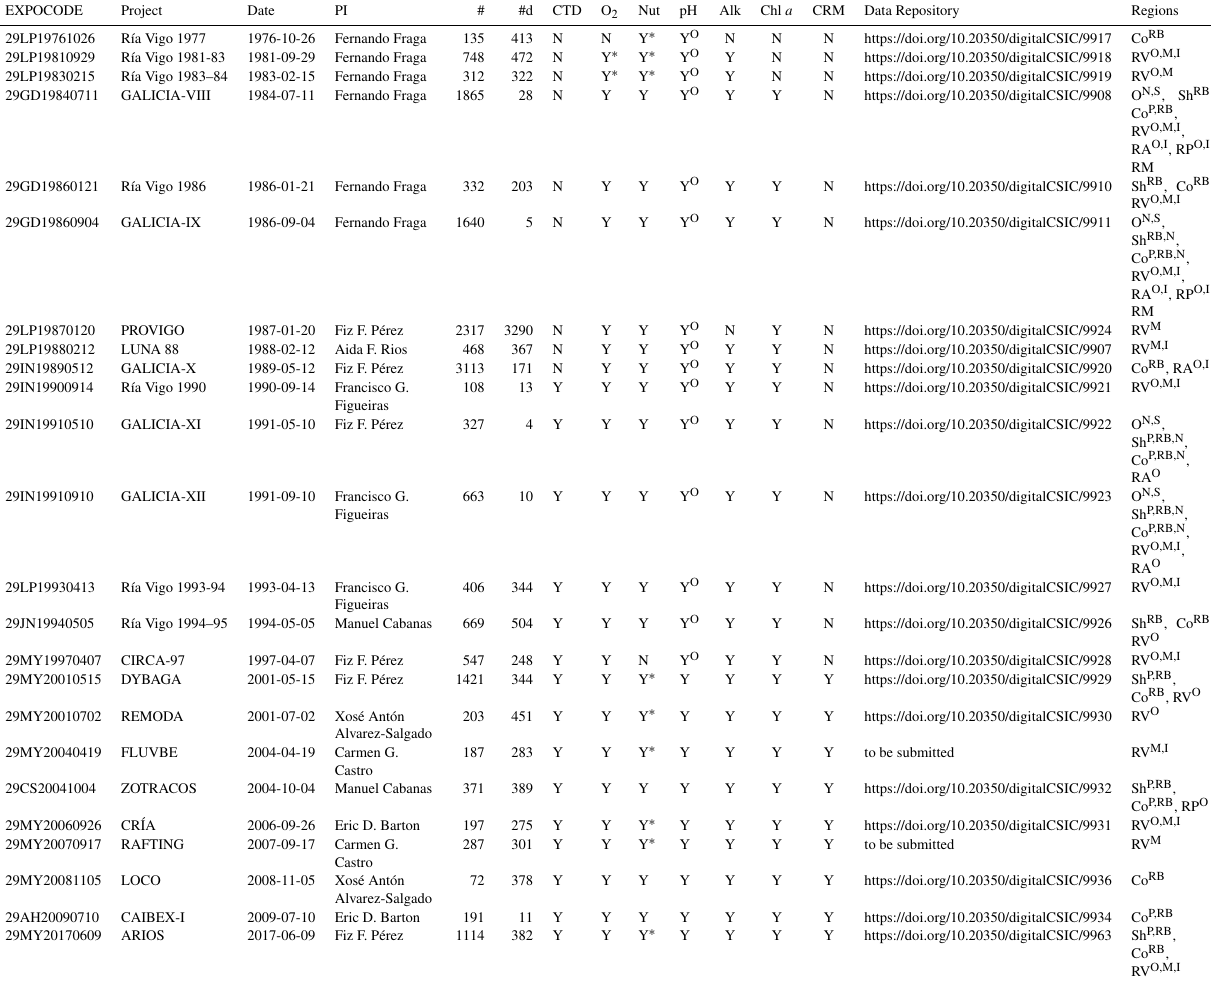
Table 1. Discrete measurements of projects gathered in the ARIOS database and associated information including dates, the principal investigator (PI), sample number (#), the number of days between the start and the end of sampling period (#d), measured parameters, link to data repository and the sampled geographical